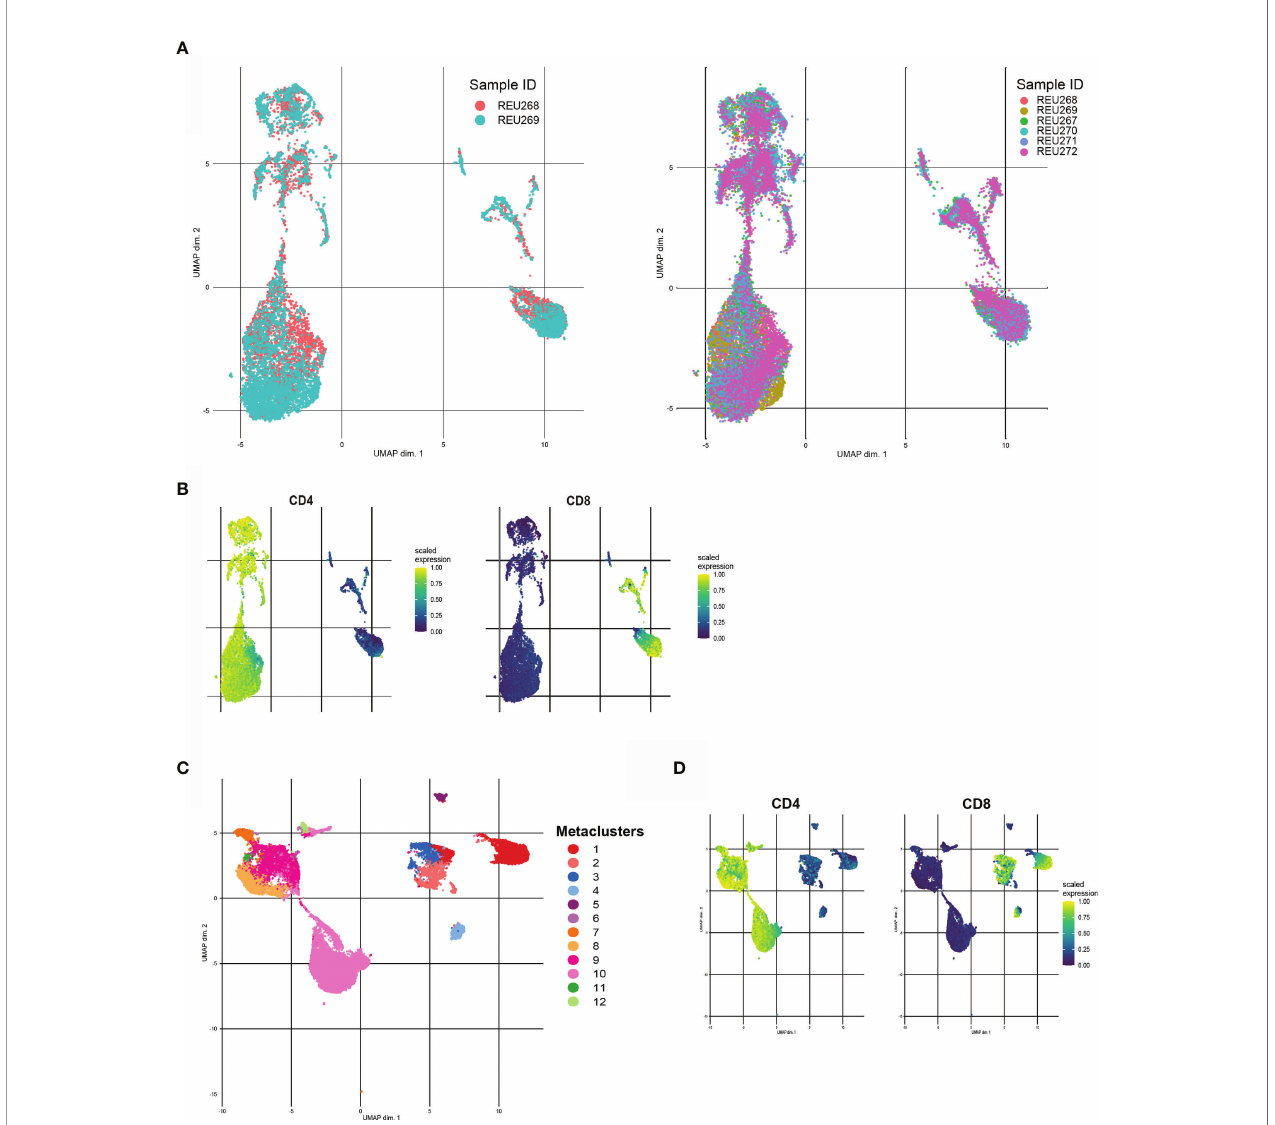
FIGURE 5 | Different examples of clustering with FlowSOM and UMAP. (A) Unsupervised UMAP generated with a training set of the data (left) and UMAP with embedded data of the test set of the data (right). (B) CD4 (left) and CD8(right) scaled median expression in embedded UMAP. (C) UMAP of downsampled healthy control data (n=6) with cluster labels generated by FlowSOM clustering and metaclusters of Consensus Cluster Plus package. (D) CD4 (left) and CD8 (right) scaled median expression in